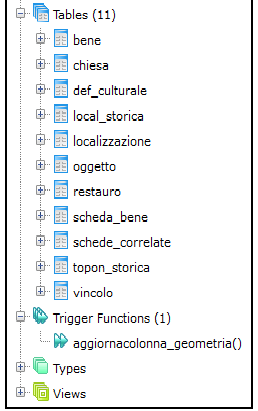
Figure 8. Trigger